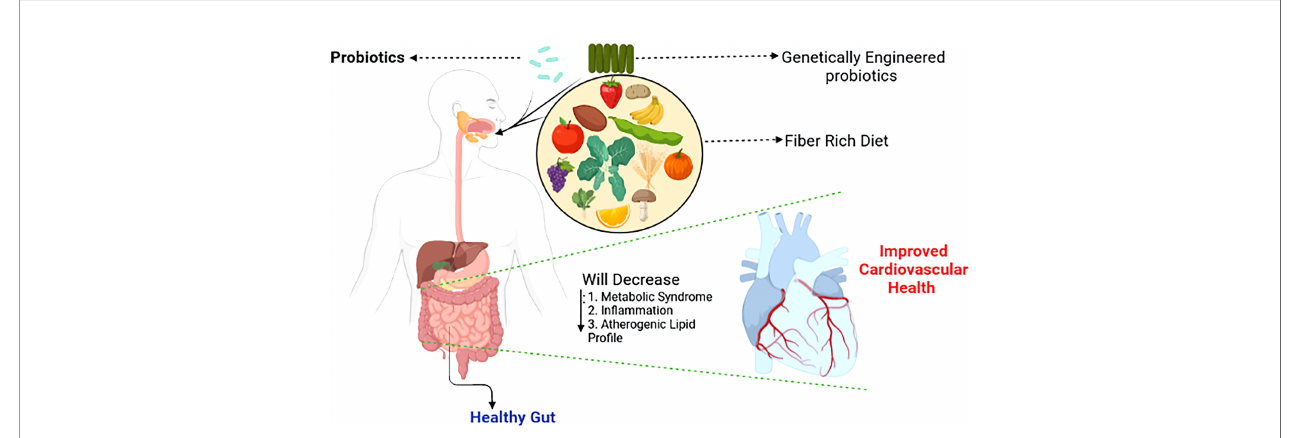
FIGURE 3 | Shaping the gut microbiotia for cardiovascular bene fi ts. Selective enrichment, using prebiotics and probiotics of bene fi cial bacteria alleviates major risk factors of cardiovascular disease (Singh et al.,